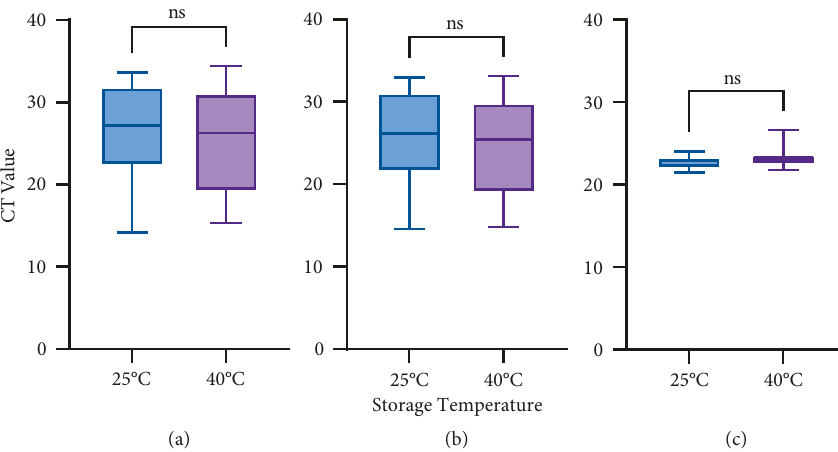
Figure 5: CT value of target genes for the resistance test. CT values of COVID-19 samples stored in VITPAD ® ITM at room temperature ( ± 25 ° C) and 40 ° C (for 3 hours): (a) ORF1ab; (b) N-gene; and (c) Internal control. ns—not statistically significant. P -value > 0.05 is considered not statistically